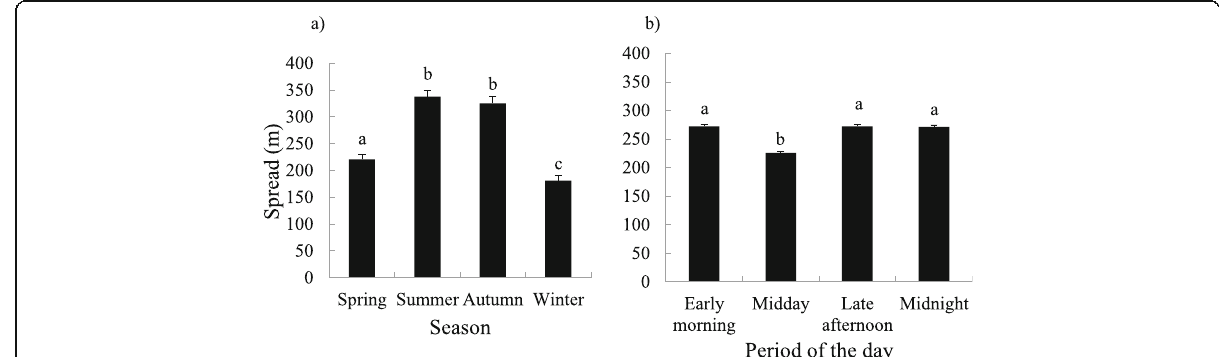
Fig. 5 Mean and standard error of the spread per season ( a ) and period of the day ( b ) of a free-ranging cattle herd ( N = 11) during eight trials of 3 weeks from September 2007 to August 2008. Periods of the day were selected as follows: (1) early morning, the first 3 h after sunrise; (2) midday, the 3 h around solar noon; (3) late afternoon, the last 3 h before sunset; and (4) midnight, the 3 h opposite from solar noon. Different letters above the bars indicate significant difference ( P < 0.01)